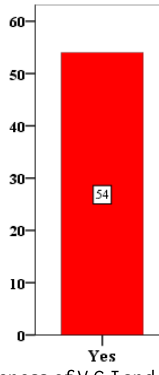
Figure 7. Awareness of VGI and freely available/accessible spatial products